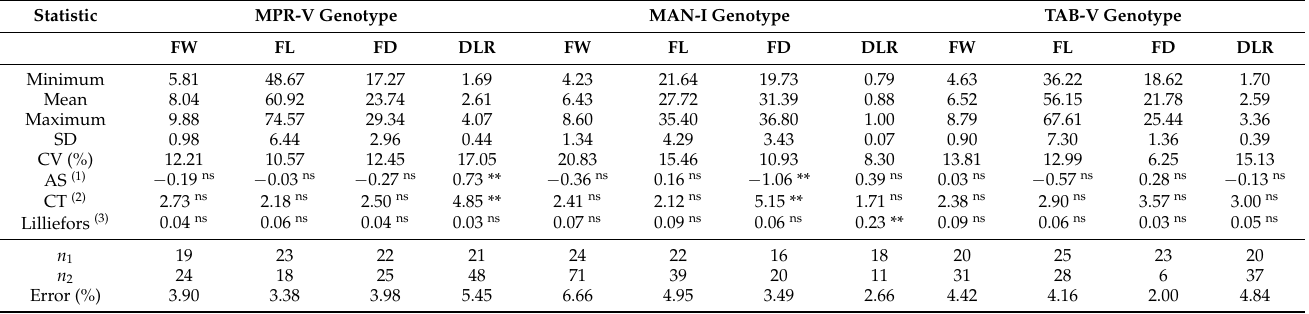
Table 3. Minimum and maximum values, arithmetic mean, standard deviation (SD), coefficient of variation (CV%), asymmetry (AS), kurtosis + 3 (CT), Lilliefors’ normality test, and recommended fruit sample size (based on simulation— n 1 and semi-amplitudes of the confidence interval— n 2 ) for the estimation of mean fruit weight (FW), fruit length (FL), diameter (FD), and diameter length ratio (DLR) of “pimenta-de-cheiro” C. chinense at 95%, reliability and semi-amplitude of the confidence interval (% Error) based on 40 evaluated